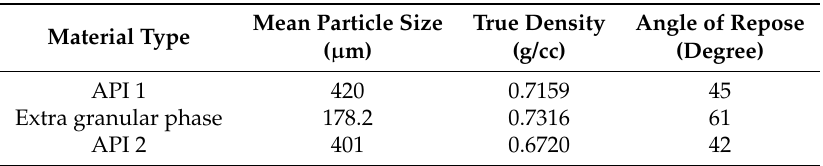
Table 1. Experimental setup. Bulk density information cannot be released to the reader, but the materials have been arranged in increasing order of bulk density.